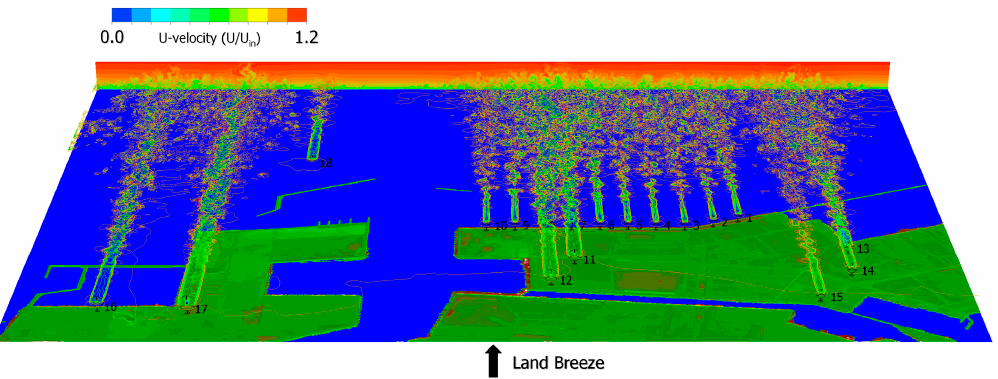
Figure A4. Instantaneous U-velocity spatial distribution at 90 m above ground level and at the outflow boundary using the CFD PD wake model (C RC = 5.0), considering an instantaneous field.